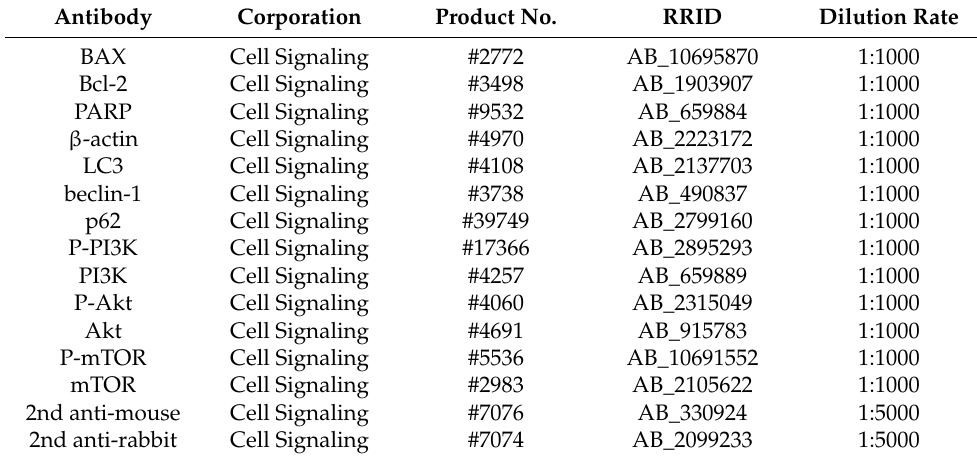
Table 1. Primary and secondary antibodies use for Western blot